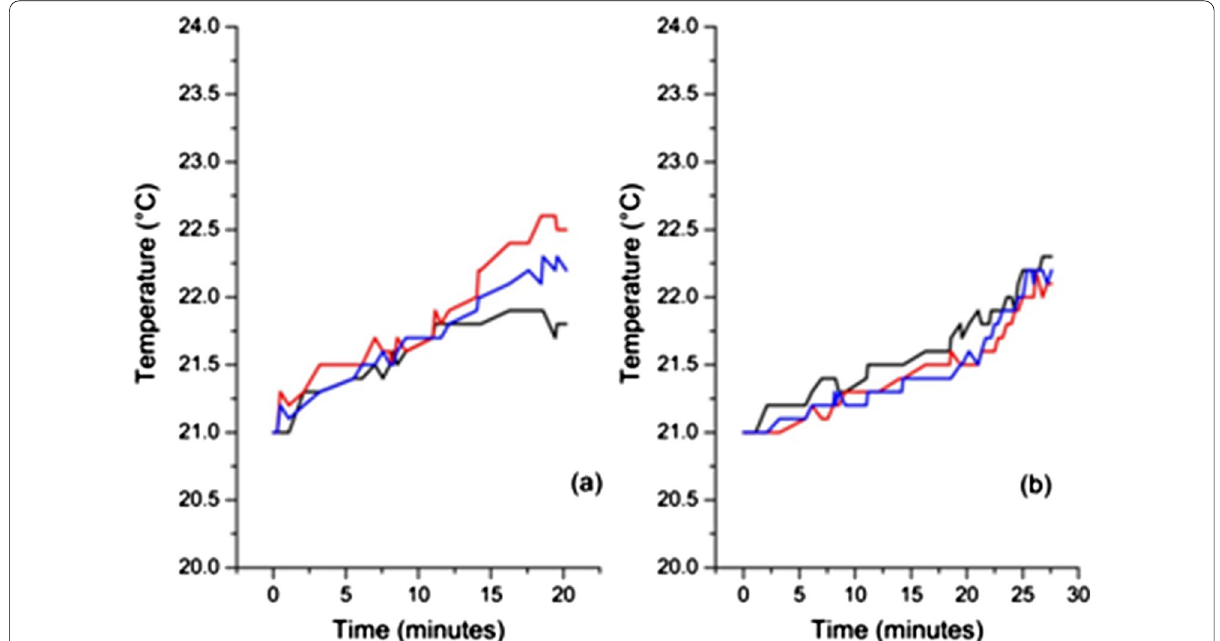
Fig. 3 The temperature over time trend of 3.0 T MRI head and body coils: a head coil: the temperature trend of the three ROIs (ROI 1 black, 2 blue, 3 red) depicted in Fig. 2a. b Body coil: the temperature trend of the three ROIs (ROI 1 black, 2 blue, 3 red) depicted in Fig. 2c